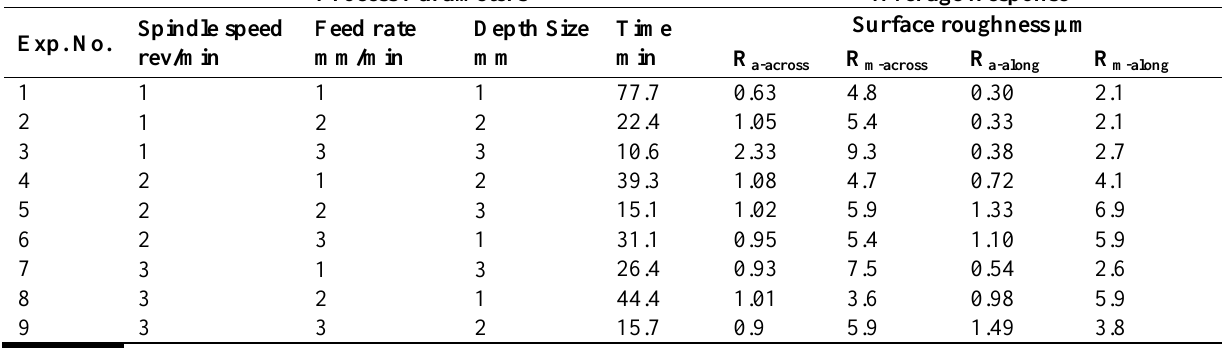
Experimental layout using an L9 orthogonal array and corresponding results. “ Process Parameters Average Response Exp. No.